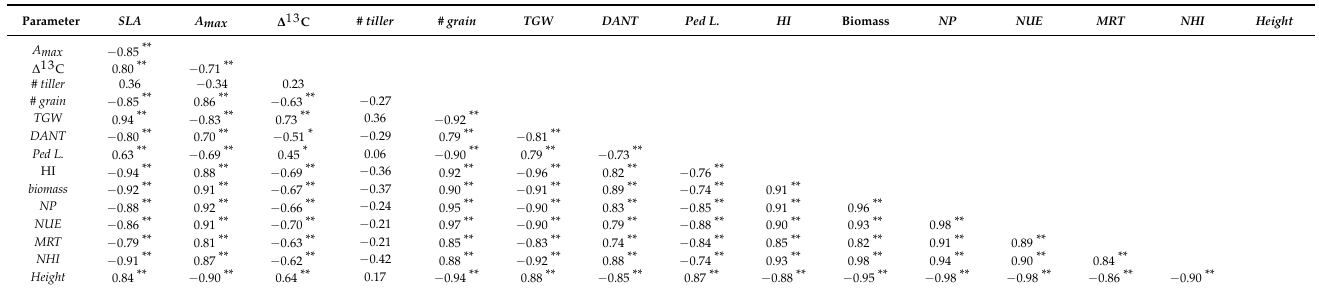
Table 2. The Pearson correlations coefficients between measured traits across all lines. Abbreviations: SLA , specific leaf area; A max , maximum rate of photosynthesis; ∆ 13 C, carbon isotope discrimination ratio; # tiller , number of tillers per plant; # grain , number of grains per spike; TGW , thousand grain weight; DANT , Number of days to anthesis; Ped L. , length of peduncle; HI , harvest index; NP , ni- trogen productivity; NUE , nitrogen use efficiency; MRT , mean residence time of N; NHI , nitrogen harvest